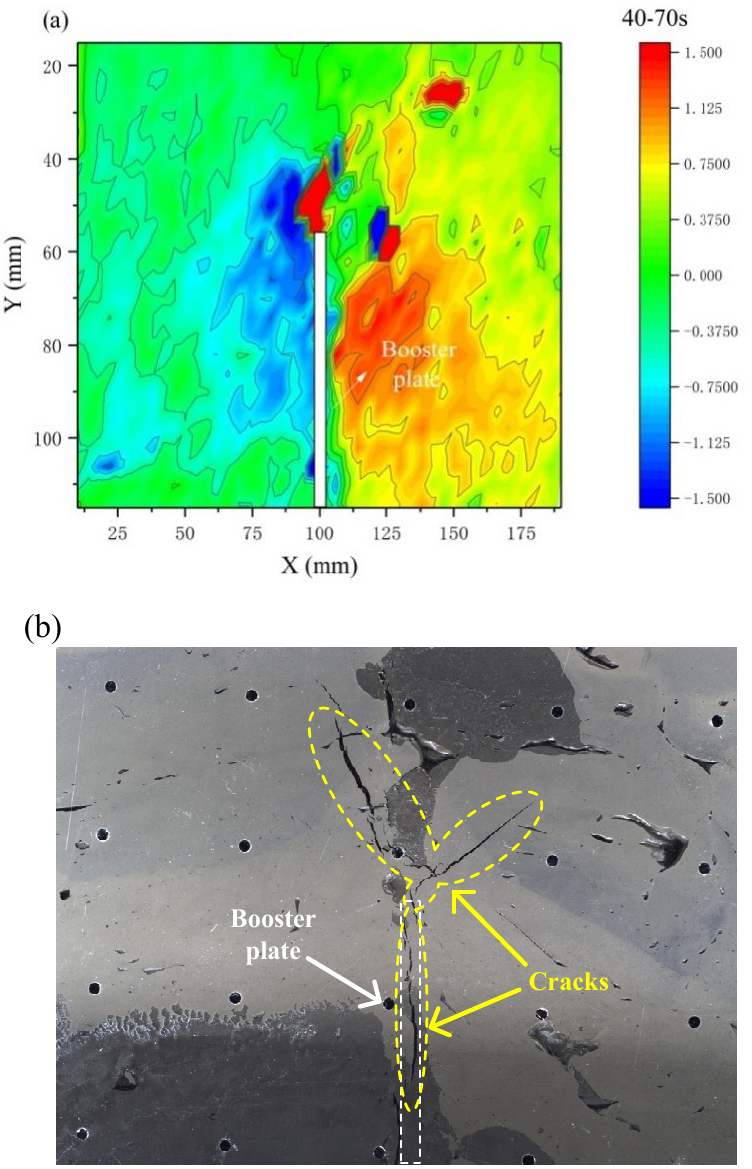
Figure 11. PIV results for a time period of 40~70 s of air boosting: ( a ) coloured contour on horizontal displacement; ( b ) slurry picture taken on time instant t * = 70 s.